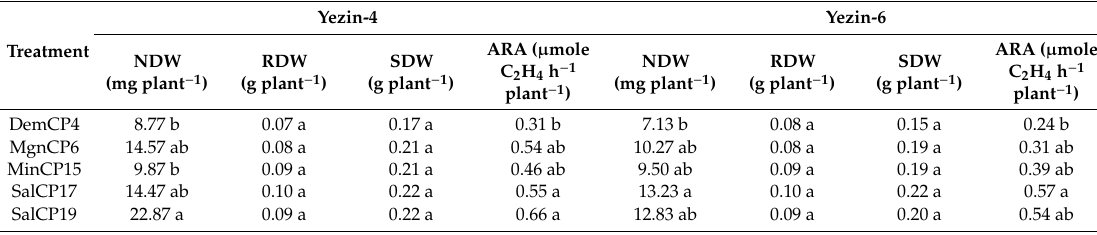
Table 5. E ff ectiveness of selected Myanmar Mesorhizobial strains on acetylene reduction activity (ARA), nodule, root and shoot dry weight of Yezin4 and Yezin6 Chick Pea varieties after four weeks.